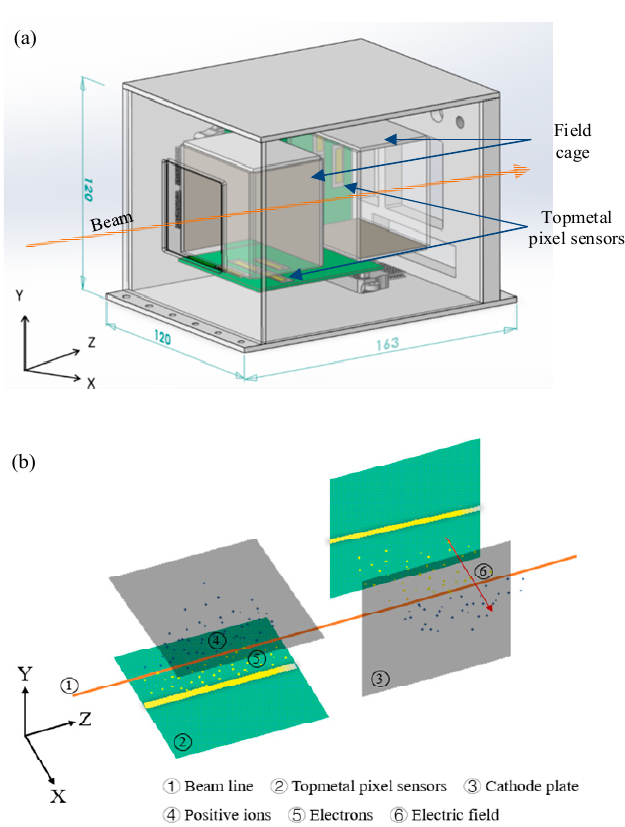
Figure 2. ( a ) Structure of the beam monitor [6]. ( b ) Working principle of the beam